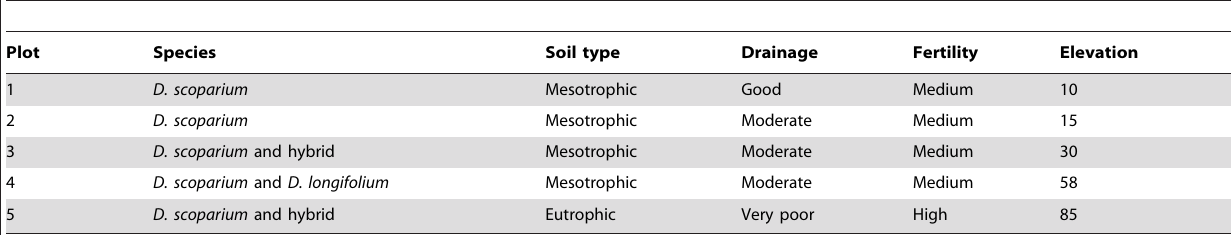
Table 1. The five plots used to assess growth-climate relationships were characterized by Dracophyllum species ( Dracophyllum scoparium , Dracophyllum longifolium , hybrid of the two species), soil type, soil drainage, soil fertility, and elevation (masl).